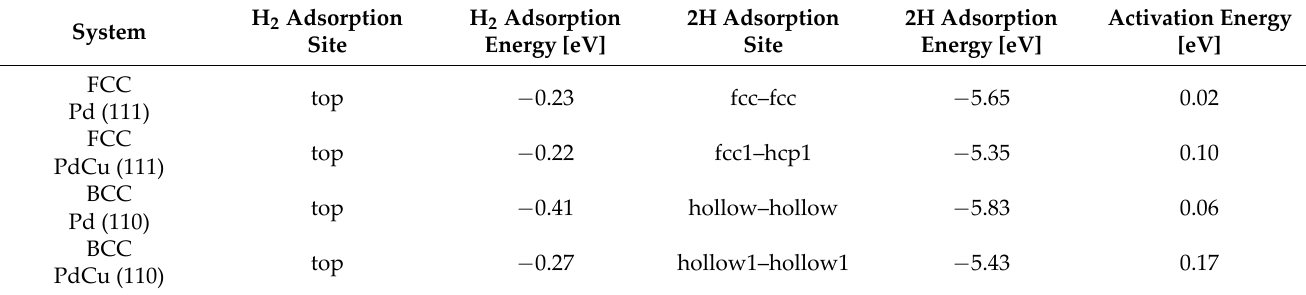
Table 2. Calculated adsorption energies of H 2 and activation energies for H 2 dissociation reaction